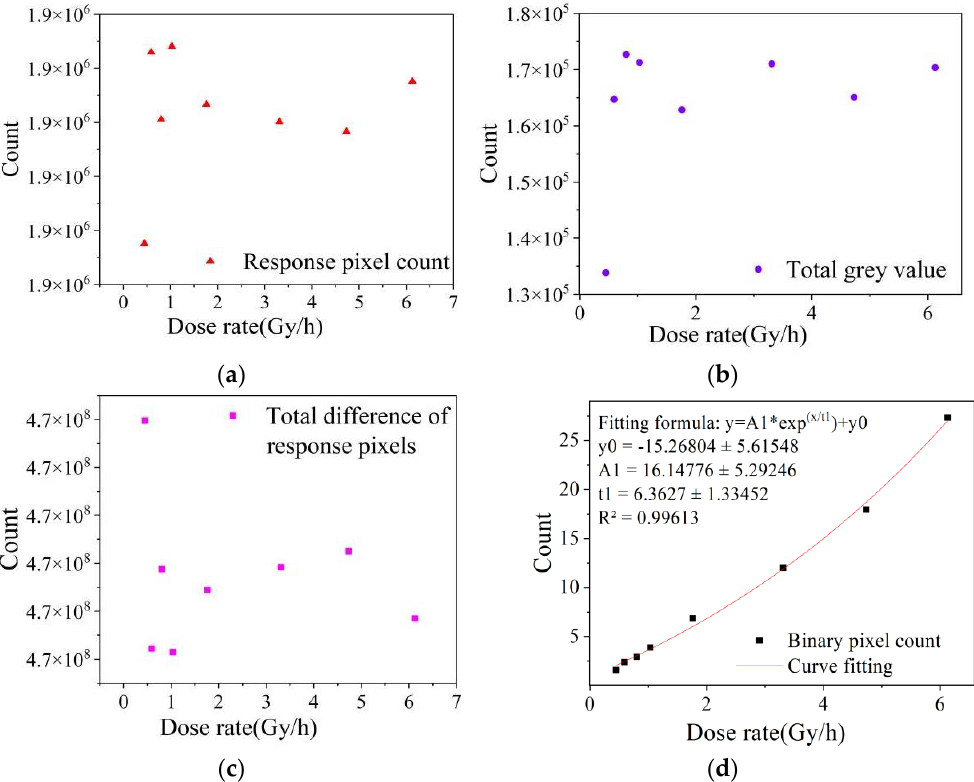
Figure 4. Image fitting data of each eigenvalue frame of calibration chamber. ( a – d ) is the fitting data of different eigenvalues in the image.